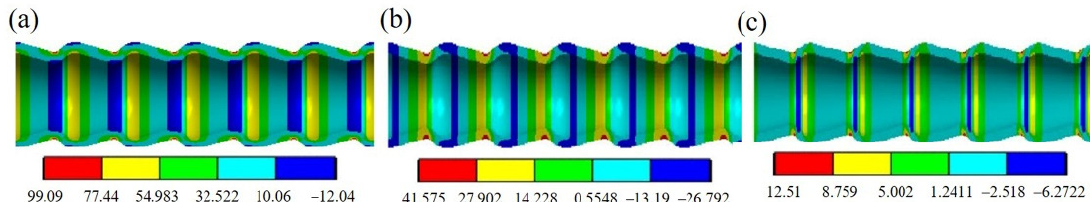
Figure 6. Stress distribution contours: ( a ) axial stress; ( b ) circumferential stress; ( c ) radial stress.